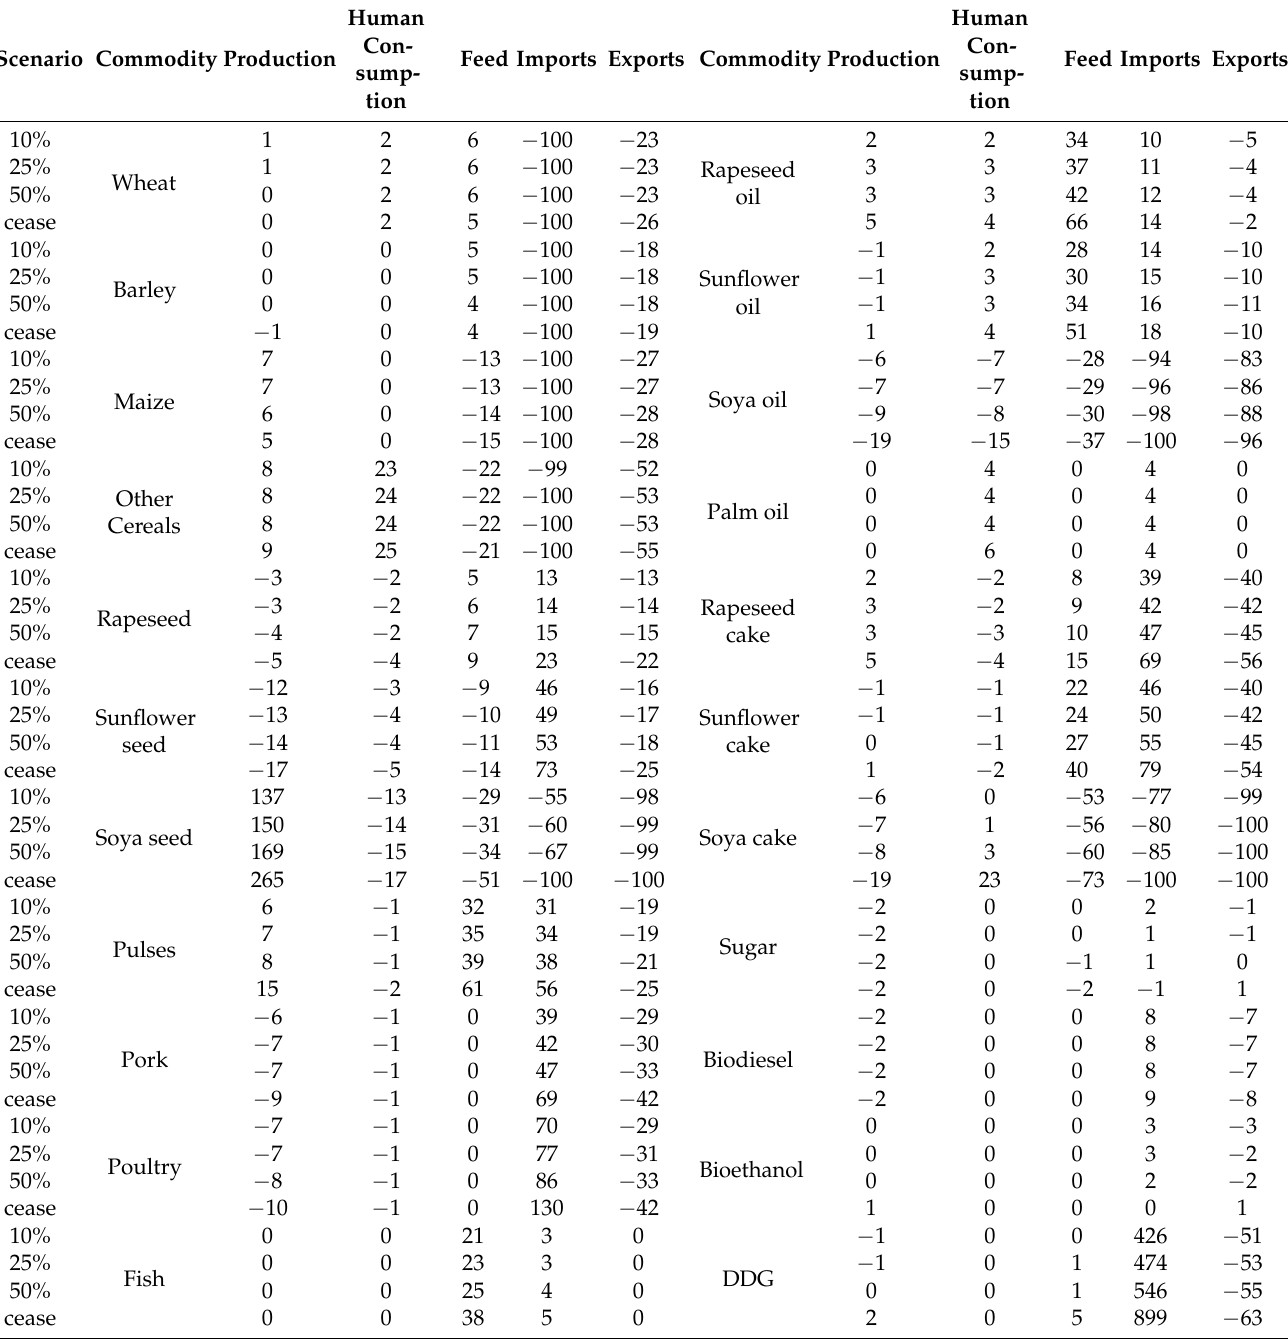
Table A2. Sensitivity analysis with respect to the import price for soy and cereals in the EU, in percentage change to baseline.